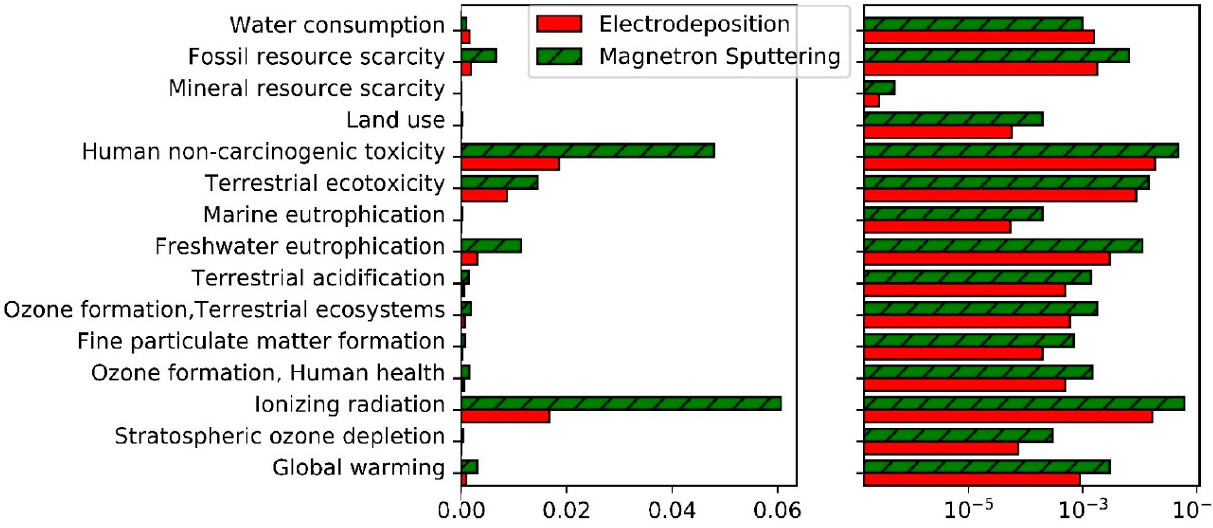
Figure 2. Normalized impacts of magnetron sputtering and electrodeposition for all impact categories excluding water ecotoxicities and human carcinogenic toxicity. Left = linear scale, right = logarithmic scale.